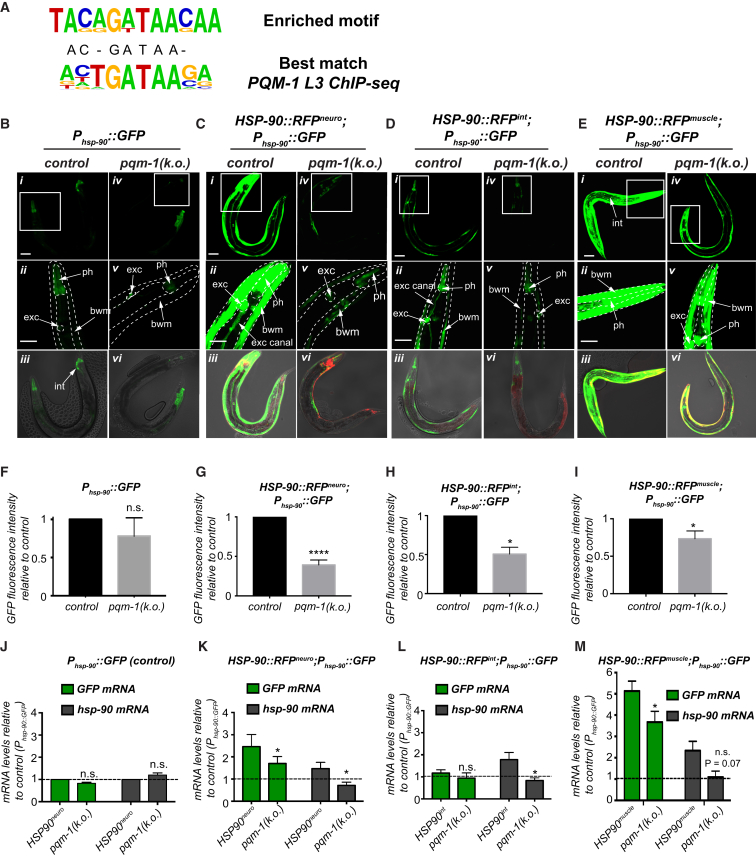
The Zinc-Finger Transcription Factor PQM-1 Mediates TCS in C. elegans(A) Ab initio motif discovery with HOMER identifies a significantly enriched motif (GATAA) in the promoters of 27 of the 34 genes upregulated in HSP-90::GFPneuro compared to control (N2).(B–E) Collapsed z stack images of young adult C. elegans expressing the Phsp-90::GFP reporter in control background (Bi), HSP-90::RFPneuro (Ci), HSP-90::RFPint (Di), and HSP-90::RFPmuscle (Ei) compared with expression of the Phsp-90::GFP reporter in a pqm-1(KO) mutant background. Expression of Phsp-90::GFP in a pqm-1(KO) mutant background (Biv), HSP-90::RFPneuro;pqm-1 (KO) (Civ), HSP-90::RFPint;pqm-1(KO) (Div), or HSP-90::RFPmuscle (Eiv). 20× magnification of the anterior (head) region (Bii, Bv, Cii, Cv, Dii, Dv, Eii, and Ev). Differential interference contrast (DIC) Nomarski, GFP, RFP overlay images. Tissues showing Phsp-90::GFP expression are indicated with a white arrow. bwm, bodywall muscle; exc, excretory cell; exc canal, excretory canal; ph, pharynx; and int, intestine.(F–I) Quantification of GFP fluorescence intensity in C. elegans expressing Phsp-90::GFP in the pqm-1(KO) mutant compared to control background (F), HSP-90::RFPneuro;pqm-1(KO) (G), or HSP-90::RFPint;pqm-1(KO) (H), or HSP-90::RFPmuscle;pqm-1(KO) (I) relative to control.(J–M) GFP and hsp-90 mRNA levels are reduced in HSP-90::GFPneuro;Phsp-90::GFP;pqm-1(KO) (K), HSP-90::GFPint;Phsp-90::GFP;pqm-1(KO) (L), and HSP-90::GFPmuscle;Phsp-90::GFP;pqm-1(KO) (M), but not in Phsp-90::GFP;pqm-1(KO) (J) relative to the Phsp-90::GFP control strain.Scale bar, 50 μm (B–E). Bar graphs represent the mean of three independent experiments (F–M). Error bars represent ± SEM. ∗p < 0.05. ns, not significant.See also Figure S2.